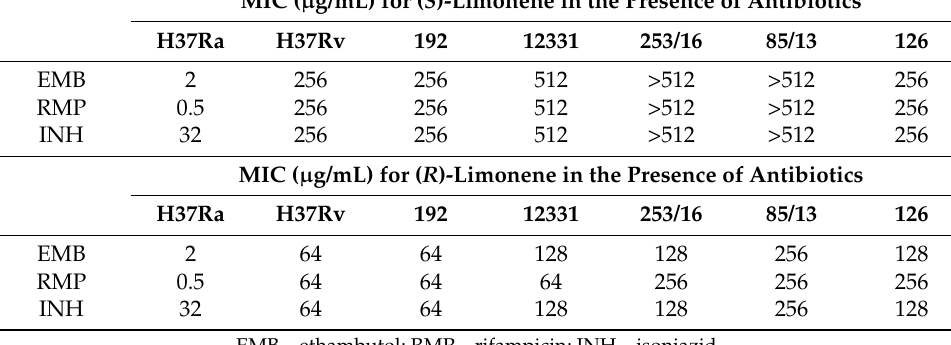
Table 5. The fractional inhibitory concentration indices obtained for combinations of terpenes and